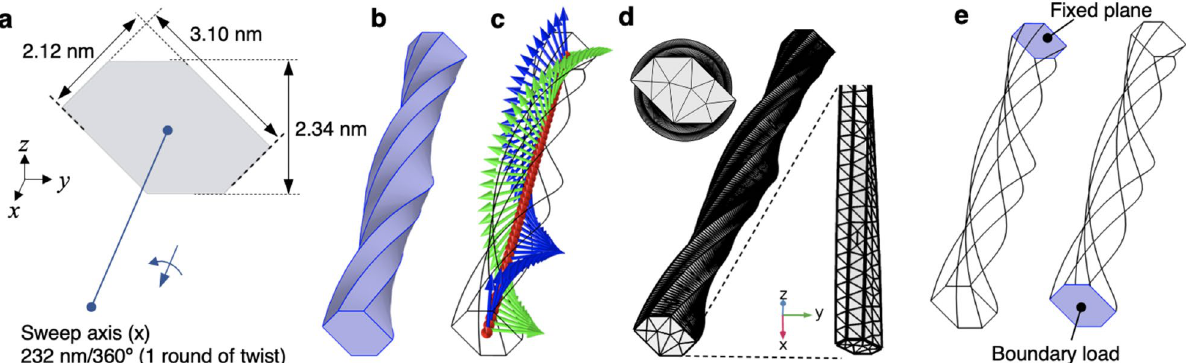
Figure 1. Mathematical modelling of a twisted CNF. ( a ) A hexagonal cross-section assuming an 18-strand crystal model was swept clockwise around the centre of gravity in the normal direction ( x axis) to create the right-handed twist contour ( b ). ( c ) Torsion of the crystal axis was reproduced by clockwise curvilinear coordinate of the second basis vectors in the y and z axes, where the orthotropic physical properties of cellulose I β crystals are linked. ( d ) A fine tetrahedral mesh was set up in the model. ( e ) The back end was fixed, and a tensile load in the x -axis direction or a bending load in the − z direction was applied to the front end.